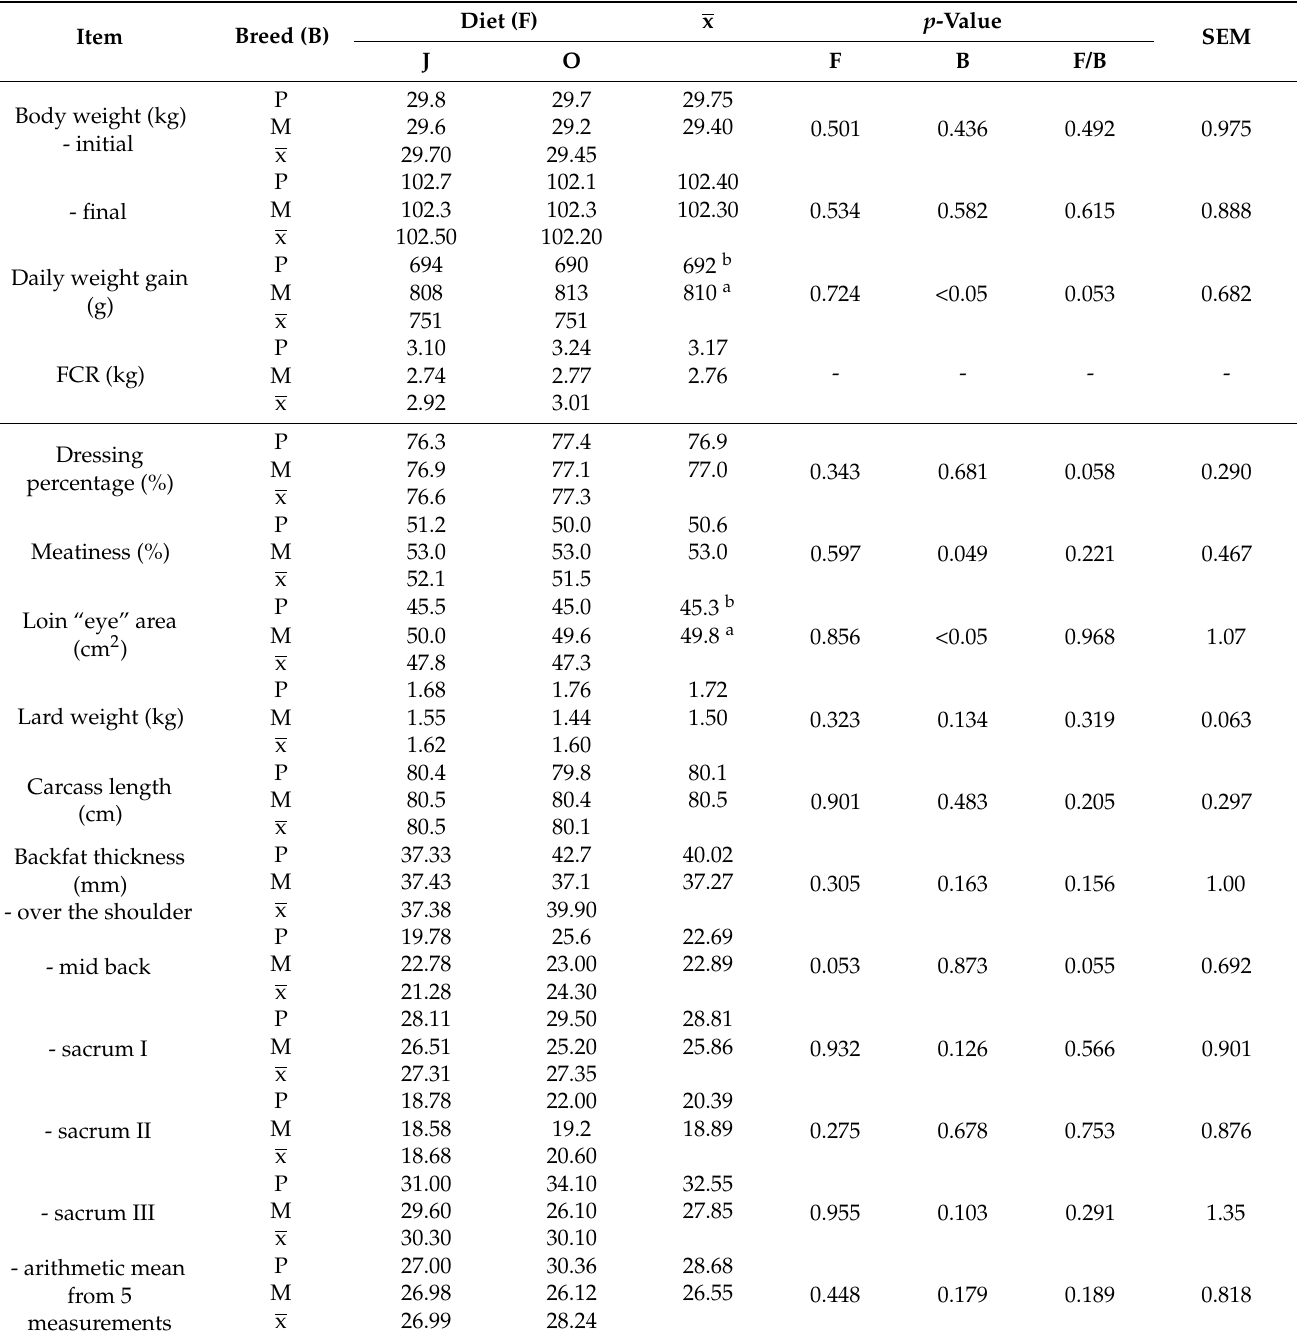
Table 3. Fattening performance and carcass